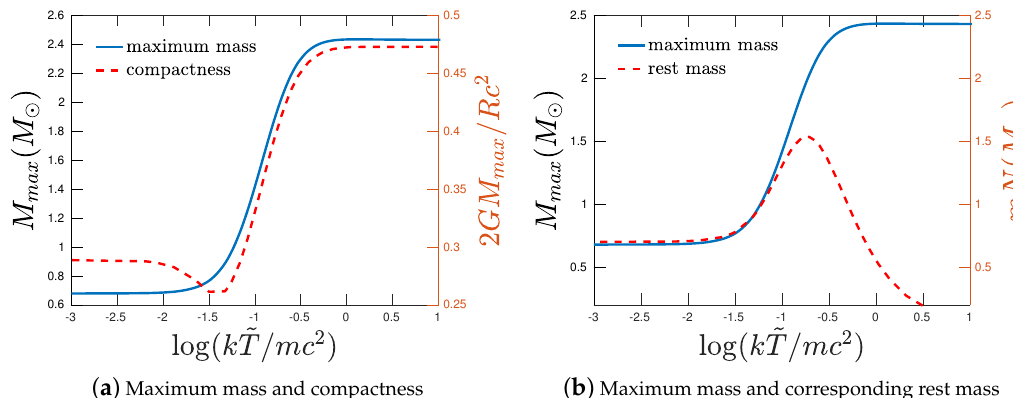
Figure 4. The maximum mass limit of ideal neutron cores w.r.t. temperature. On the left ( a ) is plotted also the corresponding compactness (red dashed line), whose scale is depicted on the right y-axis. In the right panel ( b ) is shown, together with maximum mass, the corresponding rest mass (red dashed line) at the same